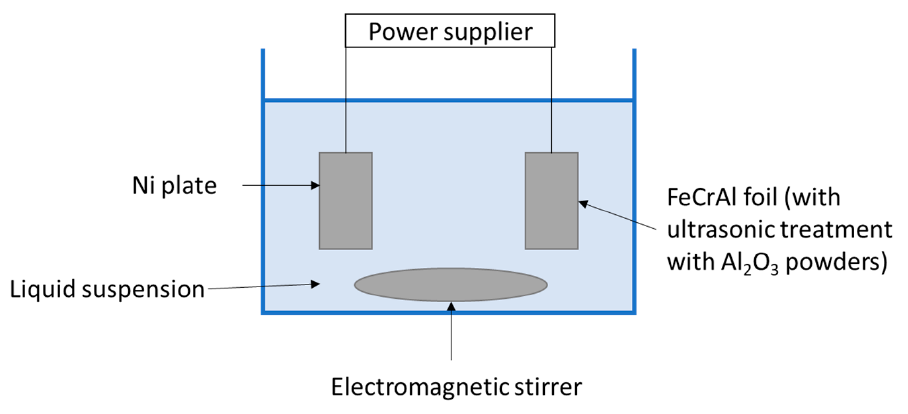
Figure 3. Schematic diagram of the electroplating process. Adapted from [38]. increase the surface area compared to the smooth surface of the substrate. This coat will protect the sintering of catalytic metal particles even at high temperatures that can go up to 1000 Degrees Celsius